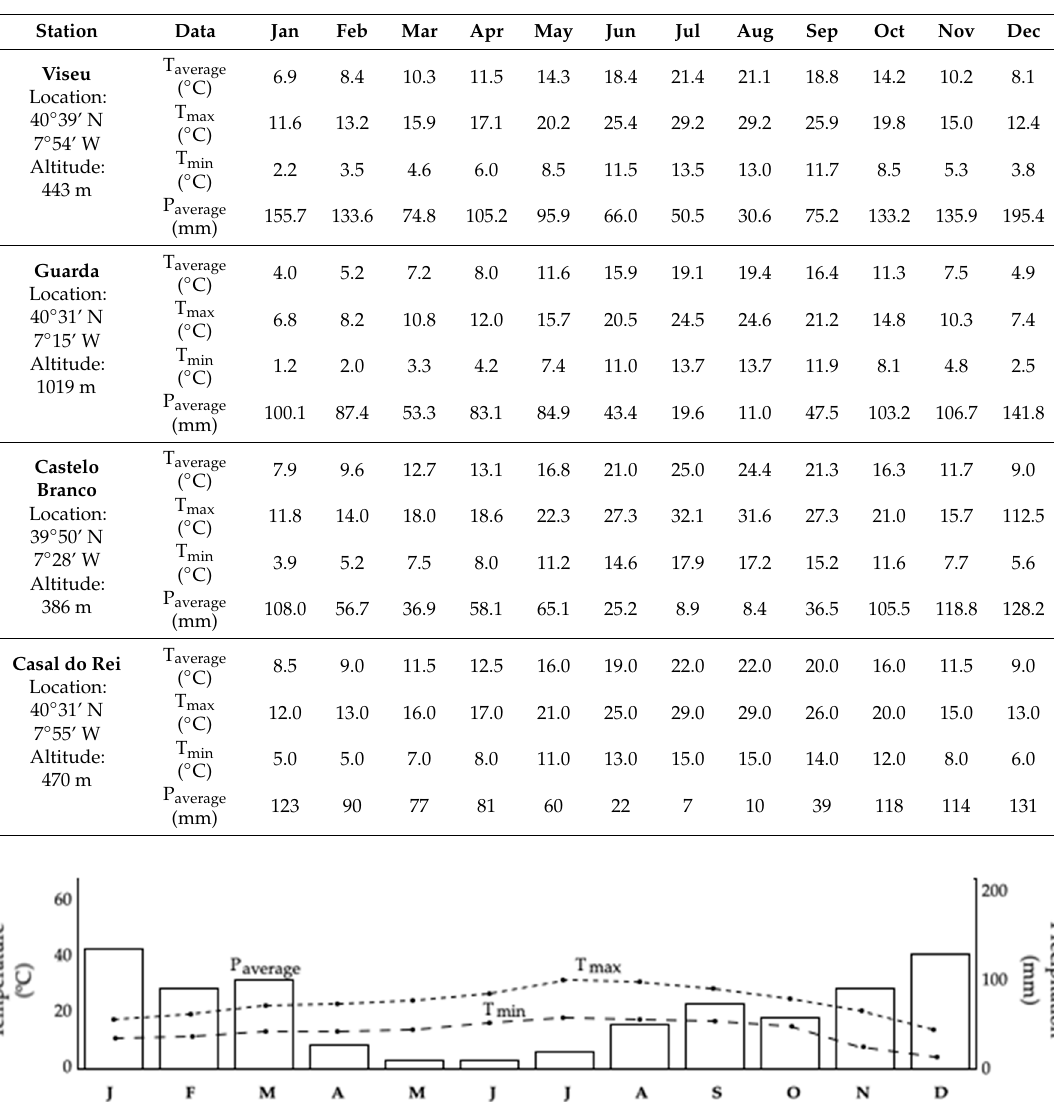
Table 1. Summary table of data collected on the website of IPMA (Instituto Portugu ê s do Mar e da Atmosfera) for the three selected stations, namely, Viseu, Guarda, and Castelo Branco, due to the proximity to the target area, and of the data modeled for Casal do Rei using the platform METEOBLUE. T average represents the average temperature, T max represents the maximum temperature, T min represents the minimum temperature, and P average represents the average precipitation.